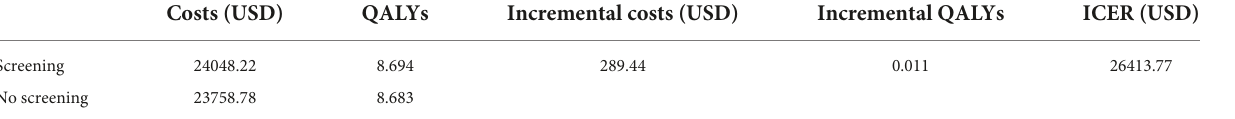
TABLE 4 Results of base case analysis.